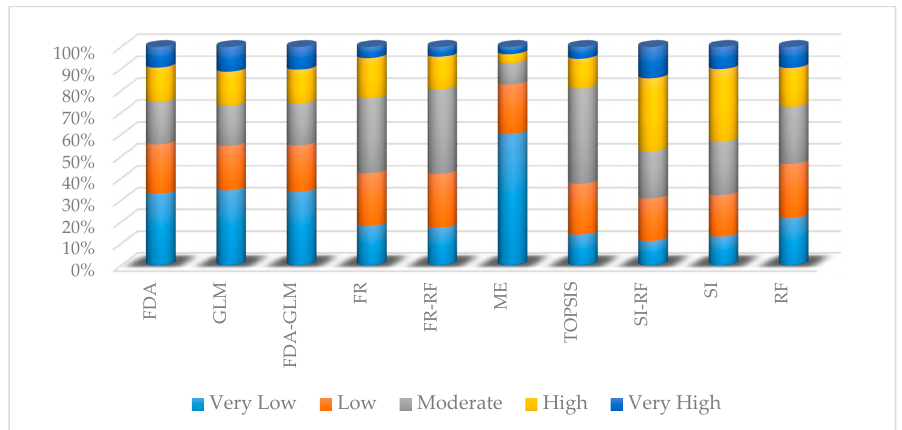
Figure 7. Percentage of each susceptibility classes in individual and hybrid models. Table 4. Values of resulted gully erosion maps using ten models.